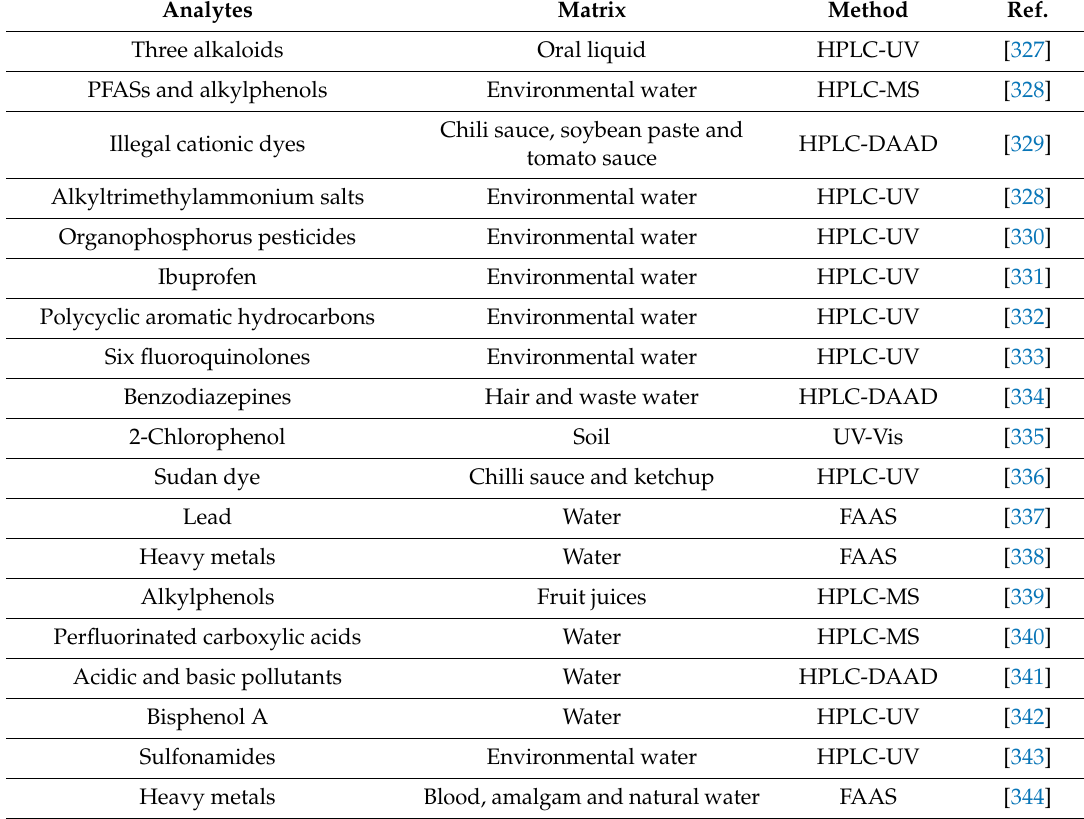
Table 5. Examples of applications of surfactants for solid phase extraction of multiple analytes from various